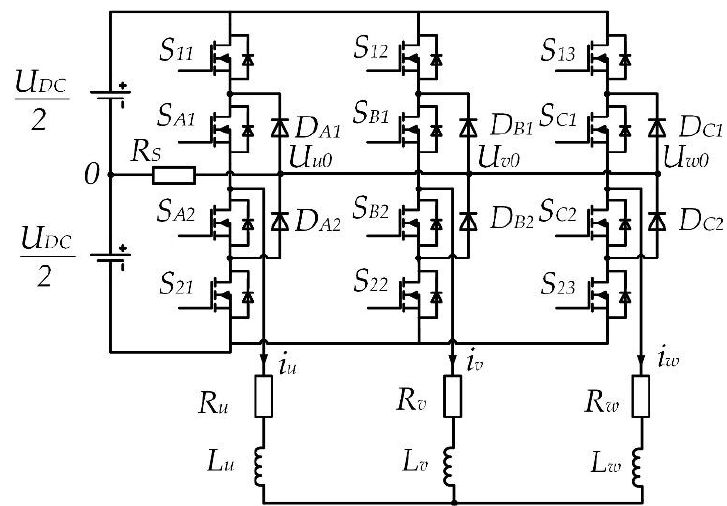
Figure 1. Schematic of a three-level DC–AC converter. Table 1. Switching states of a three-level DC–AC converter.